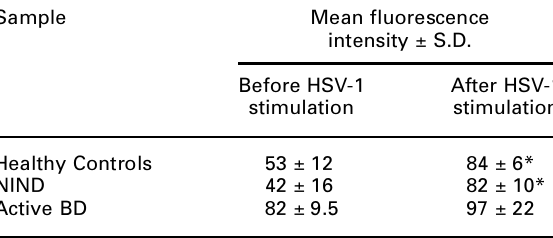
Table 3. Bcl-2 expression as mean fluorescence intensity (MFI) in peripheral blood T lymphocytes (PBL) after HSV-1 stimulation, in healthy controls ( n = 10), patients with NIND ( n = 7) and patients with active BD ( n = 12). Lymphocytes were cultured in the presence of UV-inactivated HSV-1 in an incubator with 5% CO 2 for 6 days. On the day of testing cells were washed and resuspended in RPMI 1640